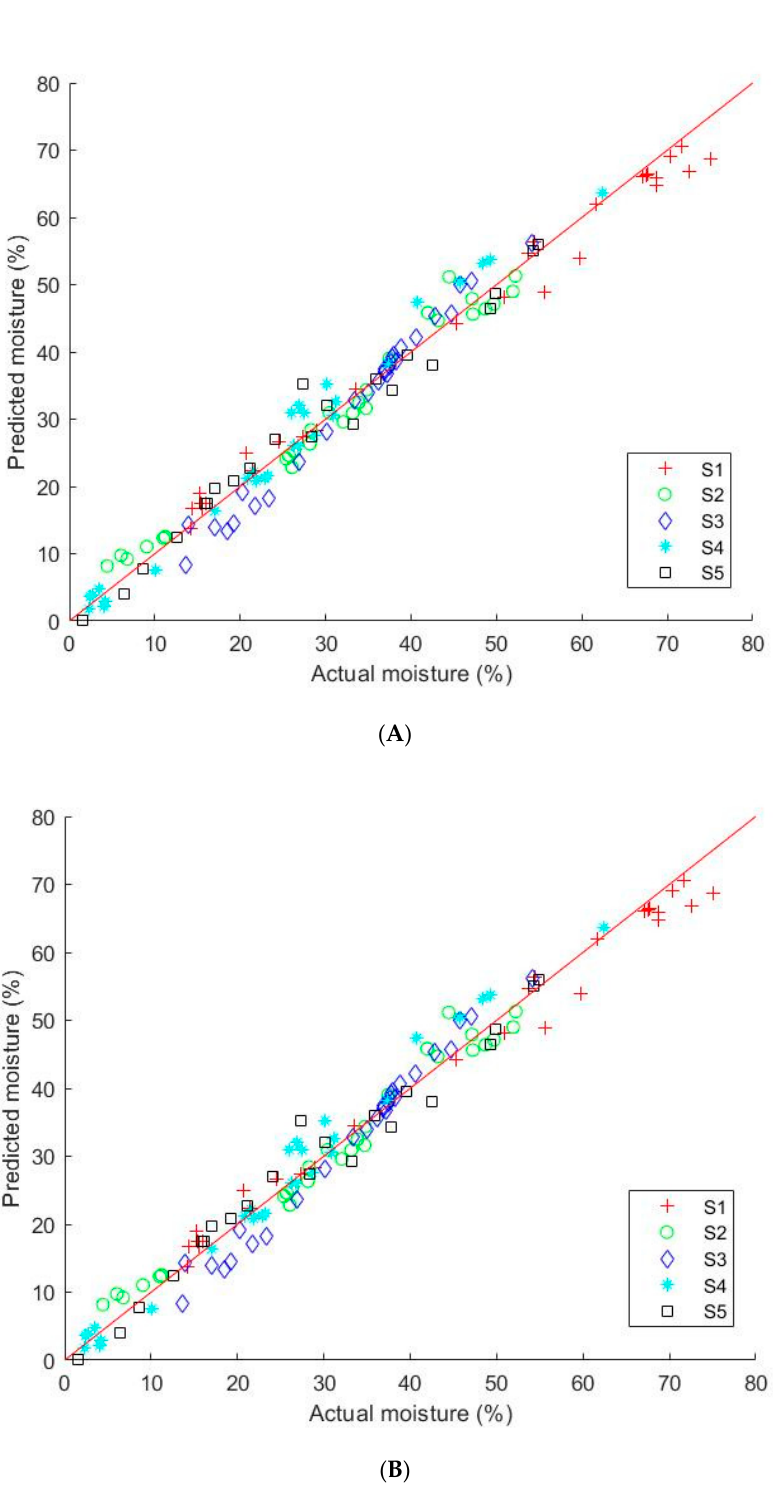
Figure 6. Moisture content prediction plot: ( A ) Calibration plot; ( B ) Prediction plot (S1: TMR; S2: mixed by-products; S3: palm kernel expeller; S4: almond pie; S5: corn bran). Preprocessing methods and partial least squares regression multivariate technique Overtones and combinations of fundamental vibrations of molecules comprising -OH, and were applied to the acquired spectra. We used the spectral data in the wavelength -NH, and -CH groups are characterized in the near-infrared (NIR) spectrum. These would absorb based on the component such as moisture content, protein, etc. [30]. The broadband peaks in the spectrum are shown in the beta coefficient graph for all the preprocessing methods in Figure 8. In Figure 8E,F, the Savitzky Golay 1st and 2nd preprocessing methods showed that the highest positive peaks were obtained around 1660 nm and 1400